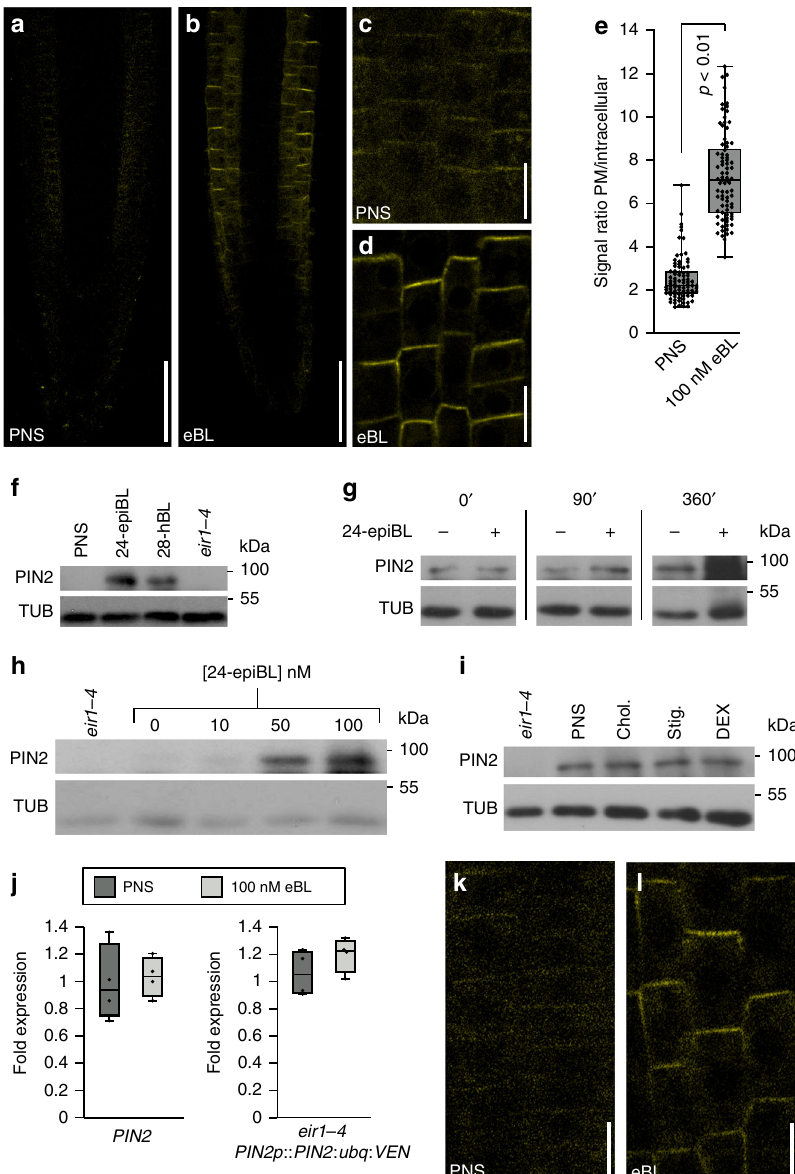
Fig. 1 Brassinolide stabilizes PIN2:ubq:VEN. a – d Comparison of eir1-4 PIN2p::PIN2:ubq:VEN root tips ( a , b ) and root epidermis cells ( c , d ) at 6 DAG germinated on PNS ( a , c ) or on PNS supplemented with 100 nM eBL ( b , d ). e PIN2:ubq:VEN signal ratios between PM and the intracellular space in PNS and eBL-treated seedlings. 82 – 85 root epidermal cells in 12 roots were tested for each dataset and analyzed by two-tailed t -test. f – i Western blots performed with eir1-4 PIN2p::PIN2:ubq:VEN membrane protein fractions isolated at 6 DAG probed with anti-PIN2; where indicated eir1-4 was used as a control. Anti- α -tubulin (TUB) was used as a loading control for all blots. f Samples either remained mock-treated (PNS) or were germinated in the presence of 100 nM 24-epiBL, or 28-homoBL. g Samples taken from a time course after 0, 90, and 360 min in the presence of 100 nM eBL ( + ) or incubated with solvent alone (-). h Samples with increasing concentrations of 24-epiBL. i Samples treated with 50 μ M cholesterol (Chol.), 50 μ M stigmasterol (Stig.), and 50 μ M dexamethasone (DEX) for 16 h, or mock-treated sample (PNS). j PIN2 transcript levels in 6-day-old Col0 and PIN2p::PIN2:ubq:VEN on PNS or on 100 nM eBL for 6 h. Four biological repetitions were made for each sample, with transcripts normalized to expression of EF1a (At1g07940). k, l PIN2:ubq: VEN distribution and abundance in root epidermis cells of RP40p::PIN2:ubq:VEN at 6 DAG, on PNS ( k ) or in the presence of 100 nM eBL for 6 h ( l ). Whiskers in box plots cover the entire range of outliers obtained in the datasets; gray boxes: fi rst and third quartiles; center line: median; dots: values obtained. Scale bars: a,b = 50 μ m; c,d = 20 μ m; k,l = 10 μ m. Source data are provided as Source Data fi